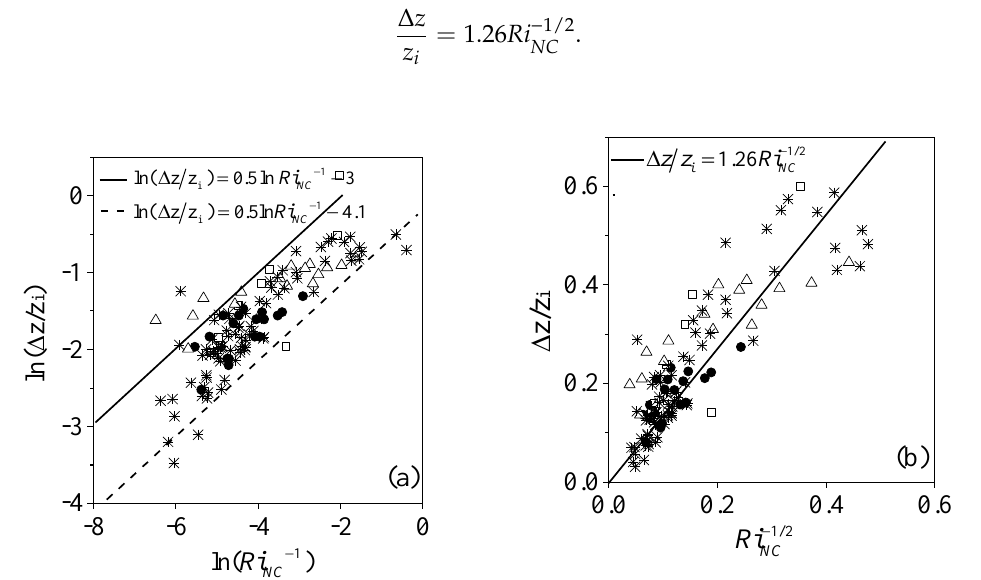
− 1/2 ) , and ( b ) ∆ z / z Figure 4. ( a ) ln ( ∆ z / z i ) plotted against ln ( Ri − 1 . The straight lines are the Ri  , and ( b ) z z  plotted against 1 ln( ) z z  and 1/2 Figure 4. ( a ) ln( ) Ri  . The straight lines are i and Ri NC NC NC i i NC best fits to the data, and the fitted formulas are labeled at the top. The (cid:8) represents the numerical the best fits to the data, and the fitted formulas are labeled at the top. The ● represents the numerical data of this paper, * represents the lidar data of Boers and Eloranta [16], (cid:3) represents the lidar data of Lothon et al. [42], and (cid:52) represents the numerical data of Otte and Wyngaard